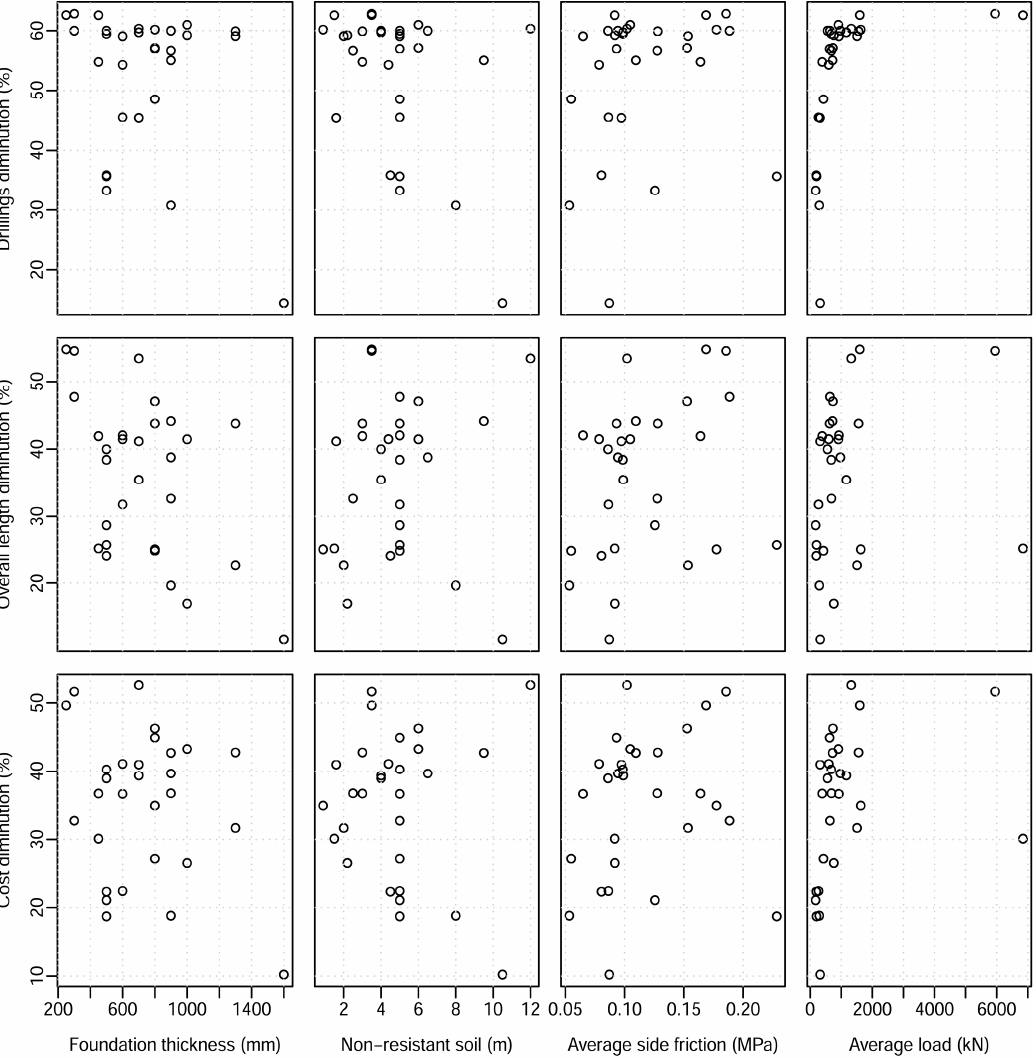
Figure 2. Diminutions of the number of drilling events (n), the overall length of micropiles ( ∑ L ), and economic savings for each retrofit project (CC), considering the thickness of the foundation, the thickness of the non-resistant layer soil, the average side friction stress ( τ f ), and the average load. The loads are a decisive factor in the cost differences between the two bond stresses that are compared. So, a more detailed analysis for each foundation element is performed. Figure 3a indicates that the number of drilling events begins to decrease when the loads are around 500 kN, and they may even be higher than 60% when the loads are greater than 700 kN. In the same way, the overall length of micropiles in each element begins to decrease when the load is greater than 500 kN (Figure 3b). However, in the case of overall length, there are some elements whose reduction is around 20% and others in which the reduction is 35–45%. The cause of this difference is the soil. Specifically, it is due to the thickness of the non-resistant soil layer, e.g., a man-made ground layer (gen- erally the top layer). When the thickness of this layer is high, not building a micropile further reduces the cost, since a length of micropile, which is not considered to be re- sistant to subsidence, is no longer built. The savings on each element can reach 60% (Figure 3c), with a graphical behavior such as that of the decrease in the overall length of micropiles (Figure 3b); so, this is the key variable when it comes to reducing costs. Fi- nally, it is also observed that the bond stress value used has no influence when the loads are below 200 kN (Table S1). So, for small loads (200–300 kN, approx.), the direct con- nection strength with two micropiles using EC2 is adequate; so, increasing the bond stress will not reduce the minimum number of micropiles established (n = 2), and the